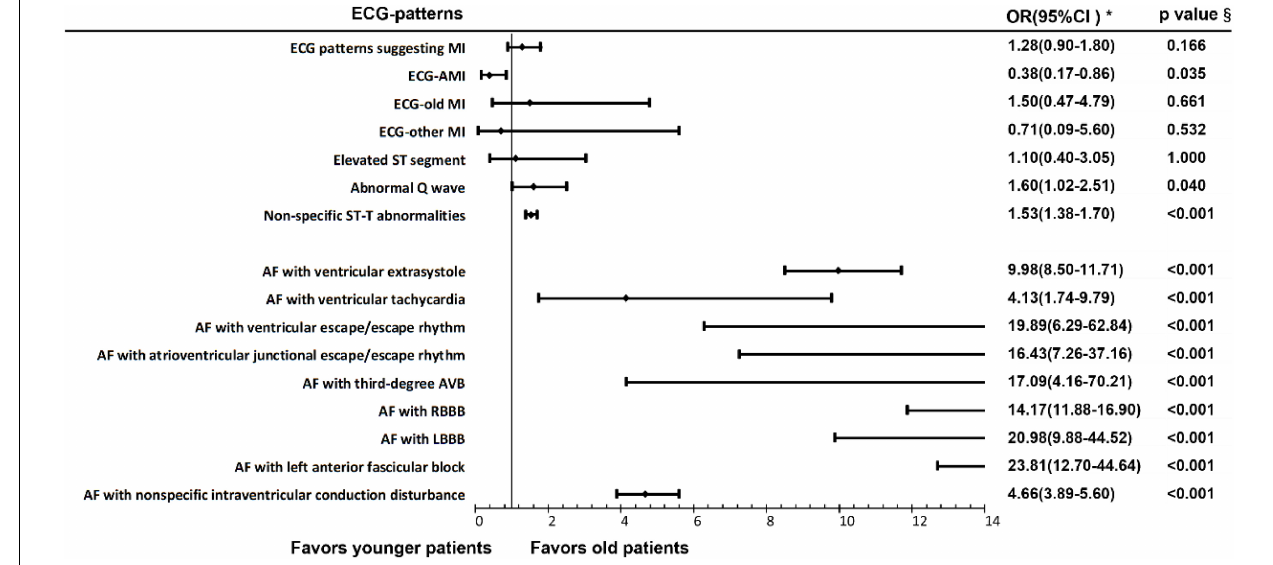
specific results are shown in Figure 3 and Supplementary Table 11